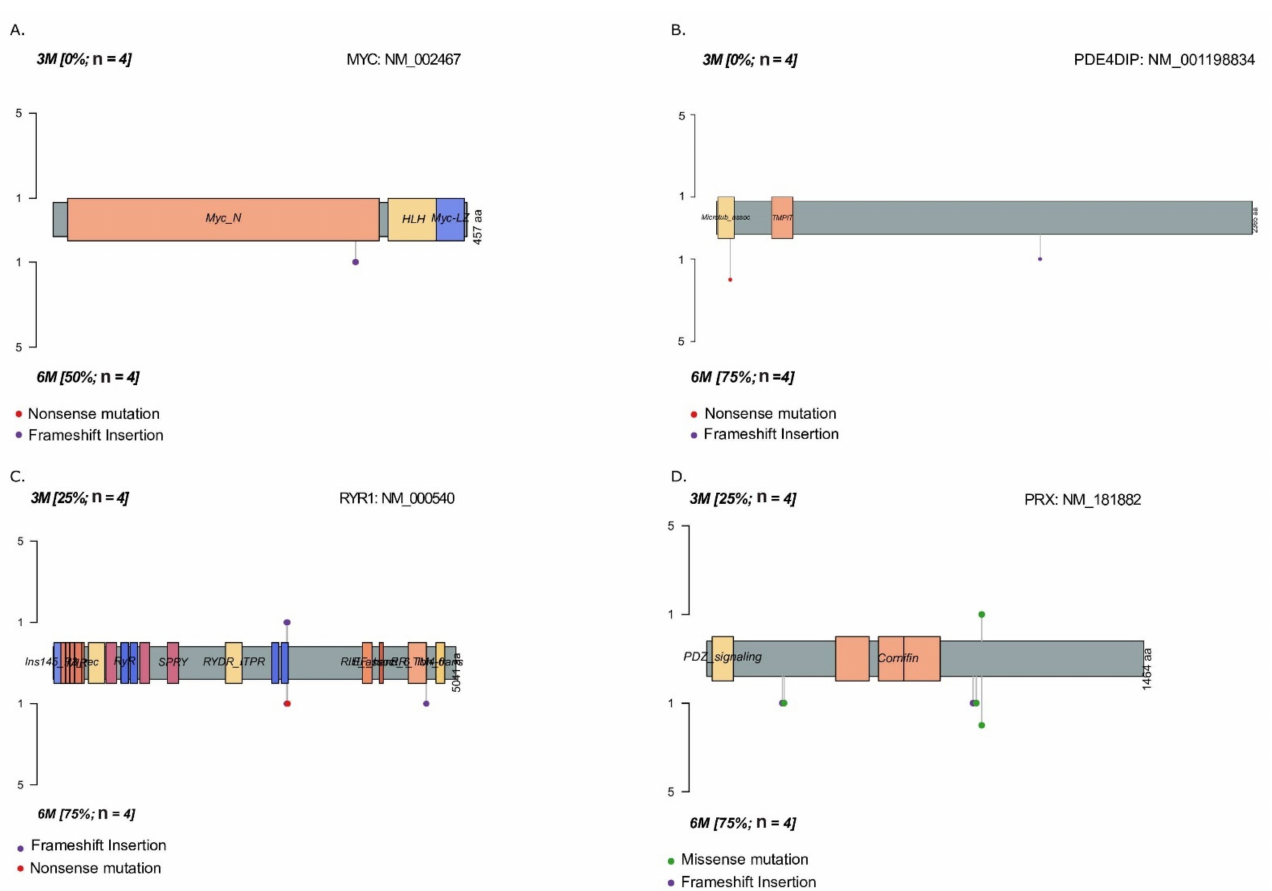
Figure 4. Mutational landscape of long-term WPSC treatment of lung cancer cell lines. Genes differentially mutated in 6-month-treated H460 samples were MYC (mutation rate 50%) and PDE4DIP (mutation rate 75%) ( A , B ), and genes differentially mutated in 6-month-treated A549 samples were RYR1 and PRX (75% mutation rate each) ( C , D